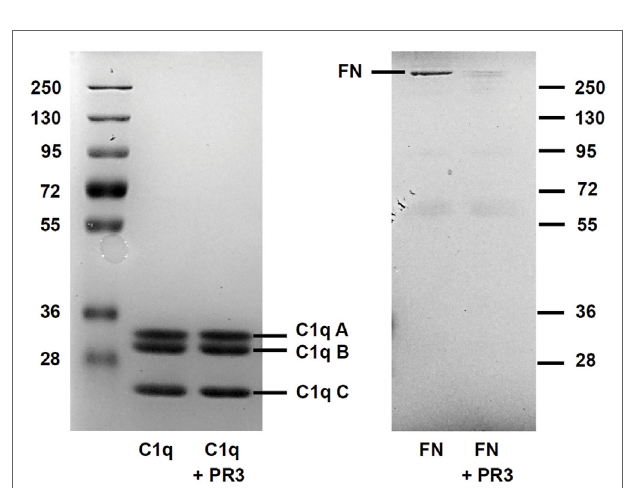
FigUre 5 | C1q is not cleaved by proteinase 3 (PR3). Fibronectin (FN) and C1q were submitted to PR3 digestion at 37°C for 18 h. The digestion products were separated on a 10% SDS-PAGE gel under reducing conditions and visualized by Coomassie staining. The position of the three (A–C) subunits of C1q and of FN is shown.